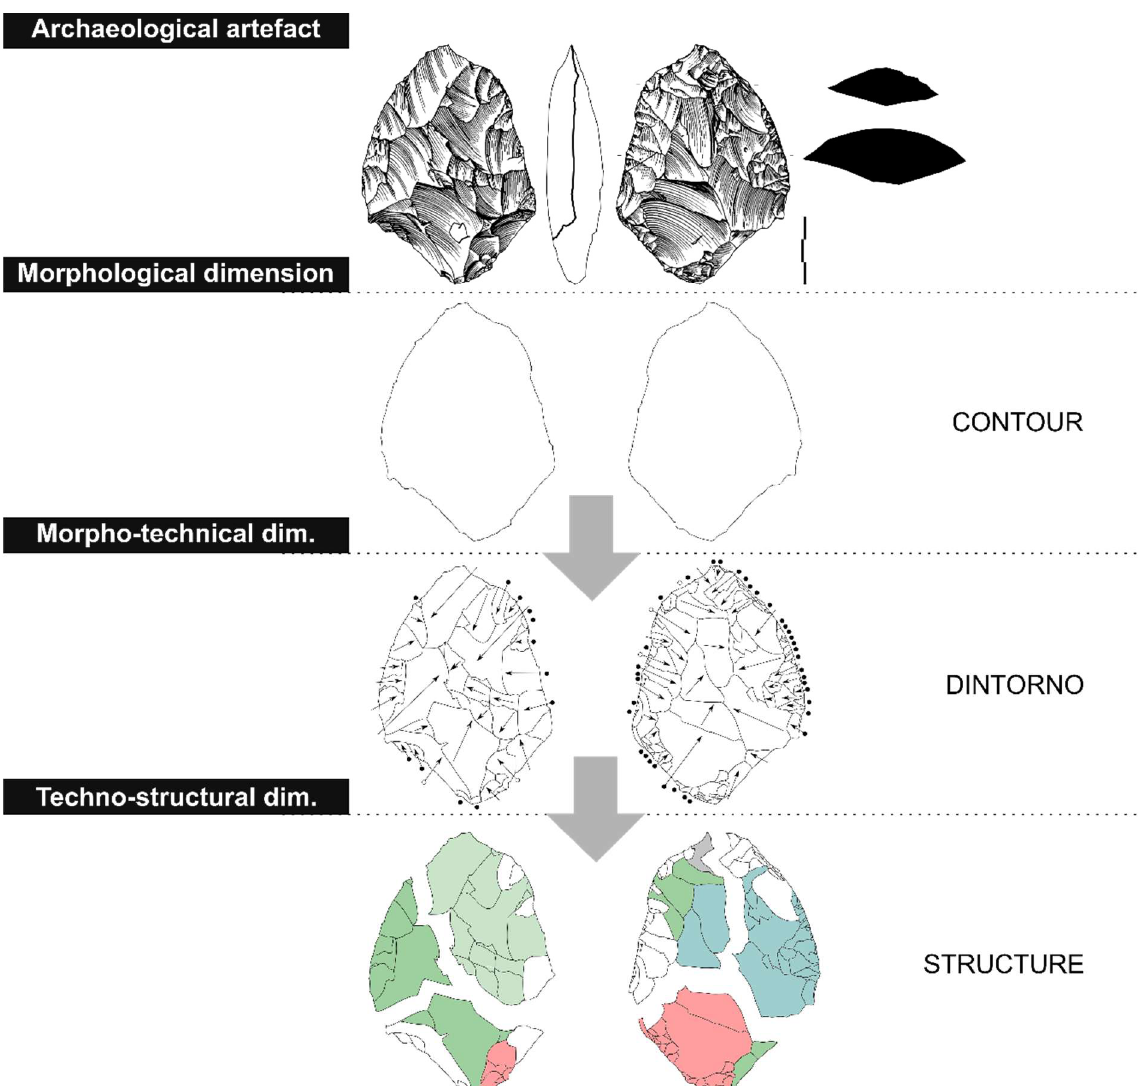
Figure 4. Example of the different analytical dimensions of an artefact depending on the approach used. What we call artefact corresponds to the object immediately found during archaeological excavations. Morphological typology favours an analysis of the contour of the object. This analysis often provides relevant information, but it must be taken into account that the contour (or what is generally called form) is only one of the technical criteria that make up the structure of the lithic piece. Technology, on the other hand, favours the study of the production of the artefact, i.e., its dintorno , the production processes contained in its outline and which gave it form. Finally, functional technology starts from the analysis of the dintorno to identify the structure of the artefact, the functional areas that allow its operative